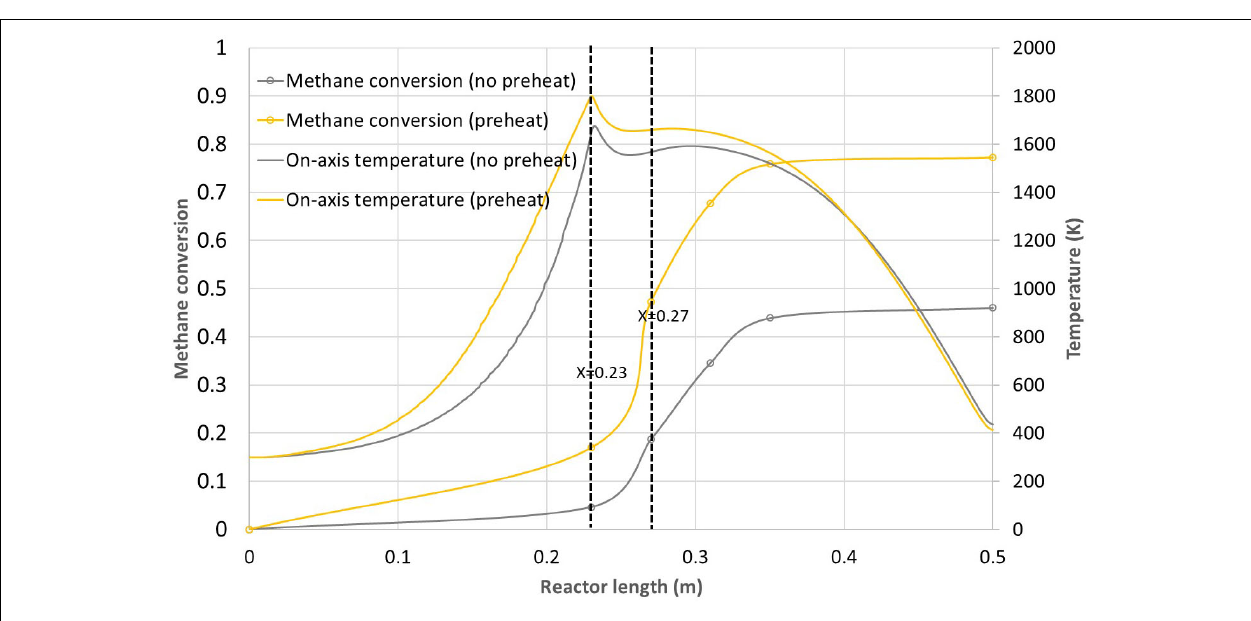
FIGURE 10 | Methane conversion and on-axis temperature vs. reactor length for the 230 mm dual tube configuration with and without